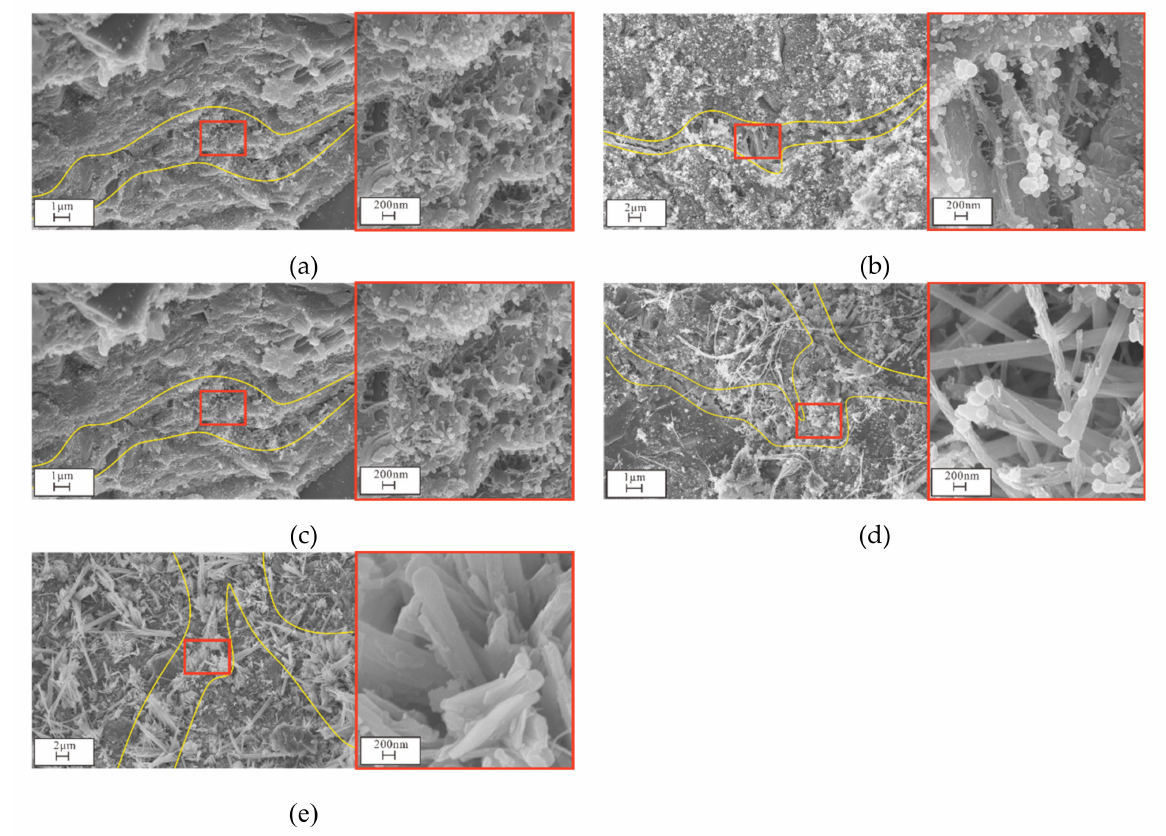
Figure 12. Crack evolution of concrete after being eroded by solutions of different concentrations for 360 days: ( a ) CS0,